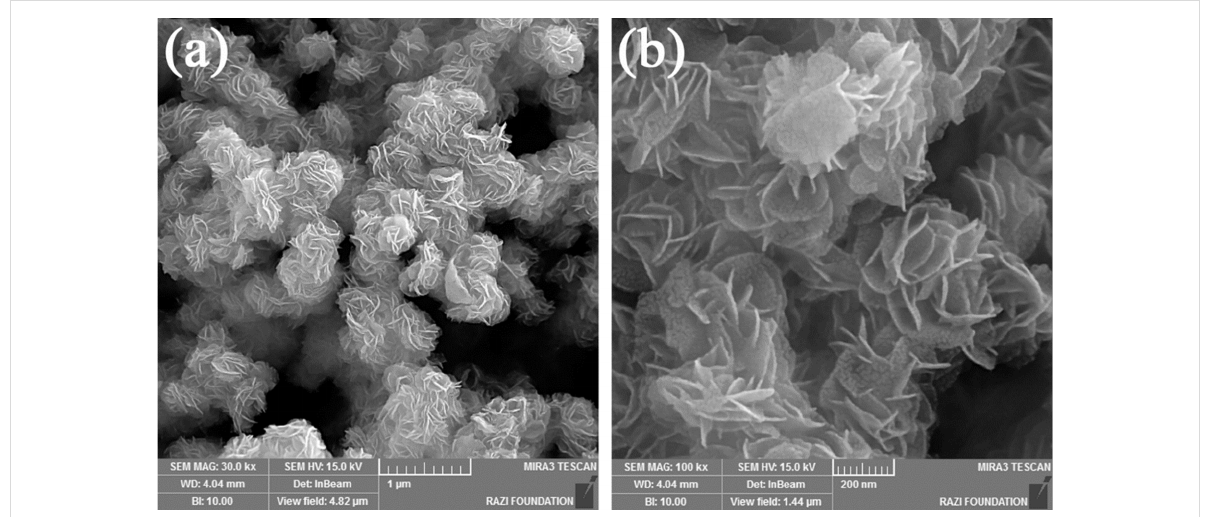
Figure 2: FE-SEM micrographs of flower-shaped MoS 2 nanoflakes synthesized via the hydrothermal method.